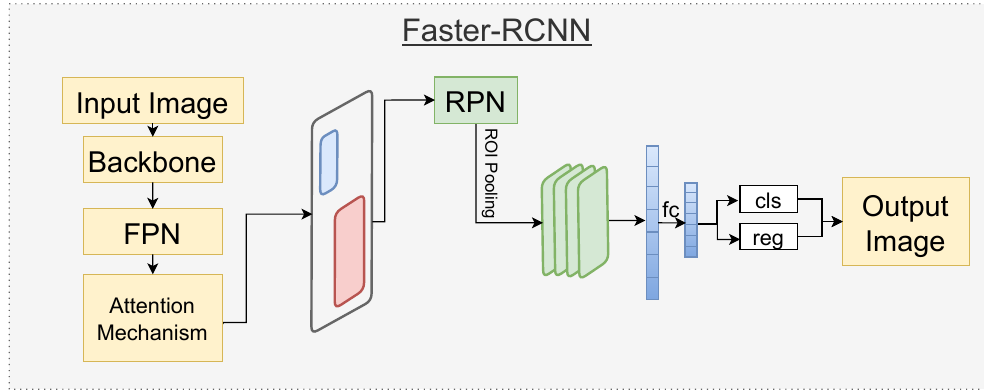
Figure 3. Flow diagram of page object detection with Faster-RCNN in detail. The features passed to the Faster-RCNN head initially passed through the Region Proposal Network (RPN) for generating proposal boxes of different dimensions. They are then aligned via ROI Pooling, to obtain fixed-size features. These features are then passed as fully connected layers (FC). Finally, the detected object is classified and a bounding box is